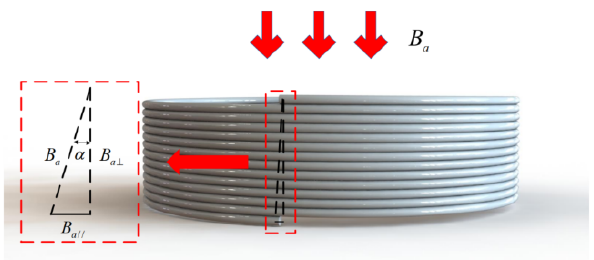
Figure 3. Schematic diagram of the axial magnetic field acting on the fiber coil.